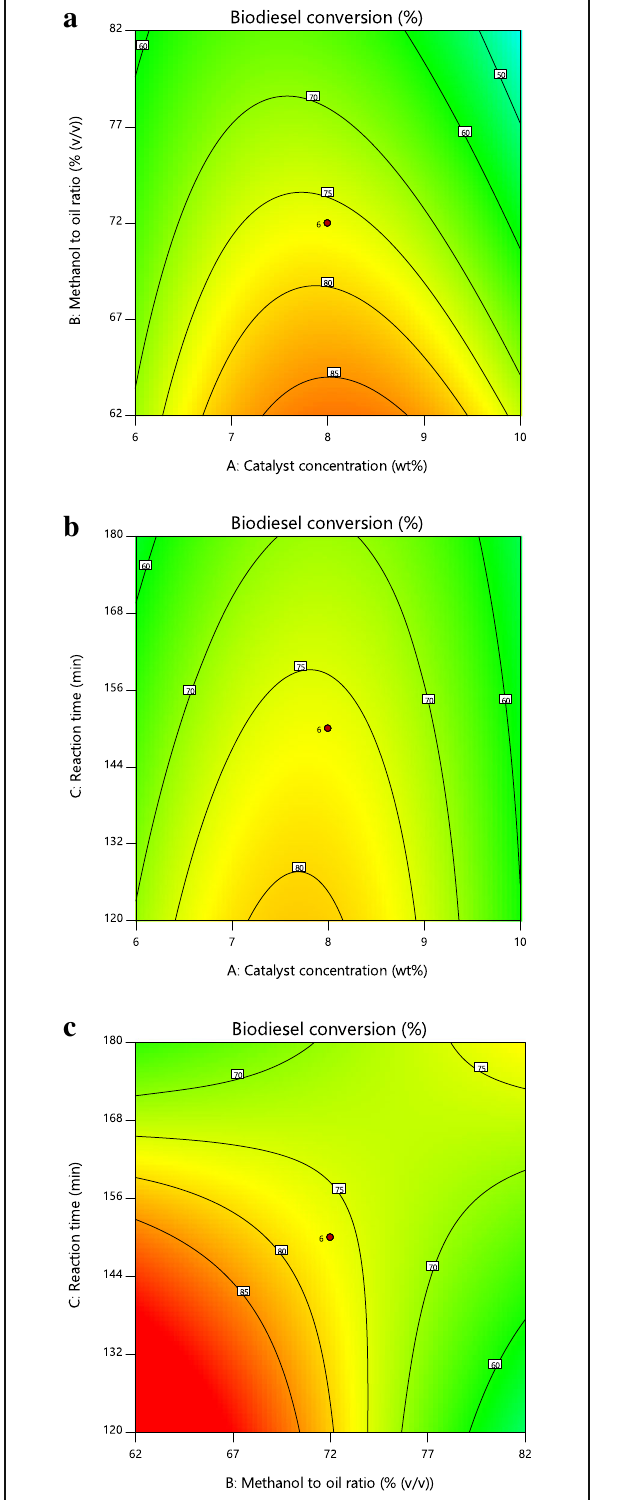
Fig. 7 Effect of individual parameters on methyl ester conversion ( a ) catalyst concentration, ( b ) methanol to oil volumetric ratio, and ( c ) reaction